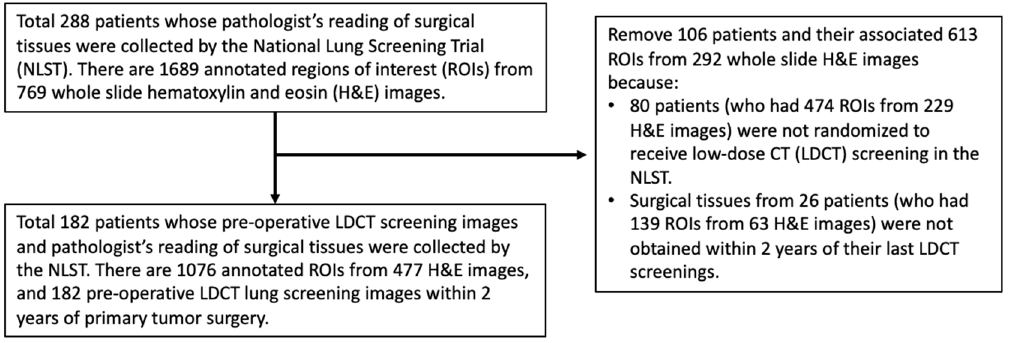
Figure 1. Study sample selection. Stage IA patients were selected from the National Lung Screening Trial who received primary tumor surgery within two years after their last LDCT screening